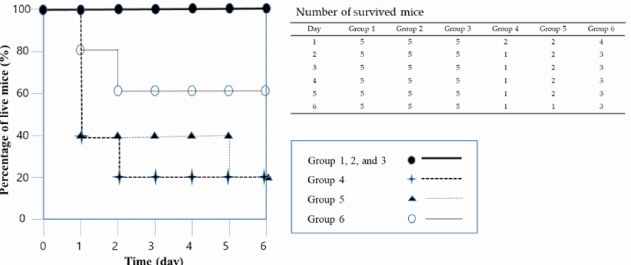
Figure 3. Protection assay results of LysSAP26 using an A. baumannii systemic infection mouse model. A mouse mortality graph and a table with raw data are presented together. Group 1: a negative control group (100 µ L of the lysis bu ff er), Group 2: first safety group (35 µ g of LysSAP26), Group 3: second safety group (70 µ g of LysSAP26), Group 4: an infection control consisting of infected mice without any treatment, Group 5: treatment with 35 µ g of LysSAP26, and Group 6: treatment with 70 µ g of